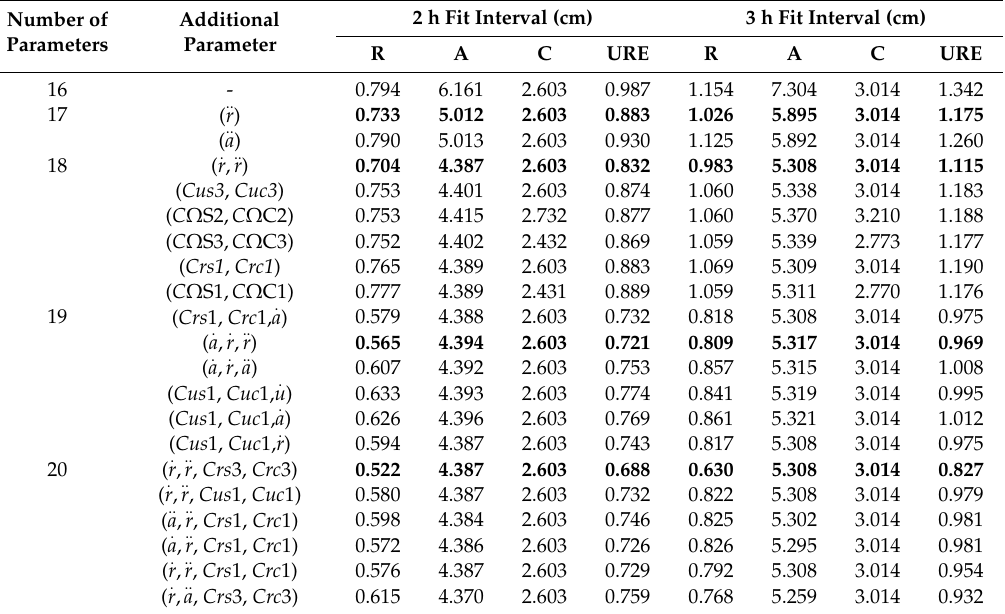
Table 4. Fit user range error (URE) and root-mean-square (RMS) fit errors in radial, along-track, and cross-track directions with 2 and 3 h fit intervals for IGSO satellite (BeiDou PRN: C07). The parts in bold represent the best fit URE for the same number of